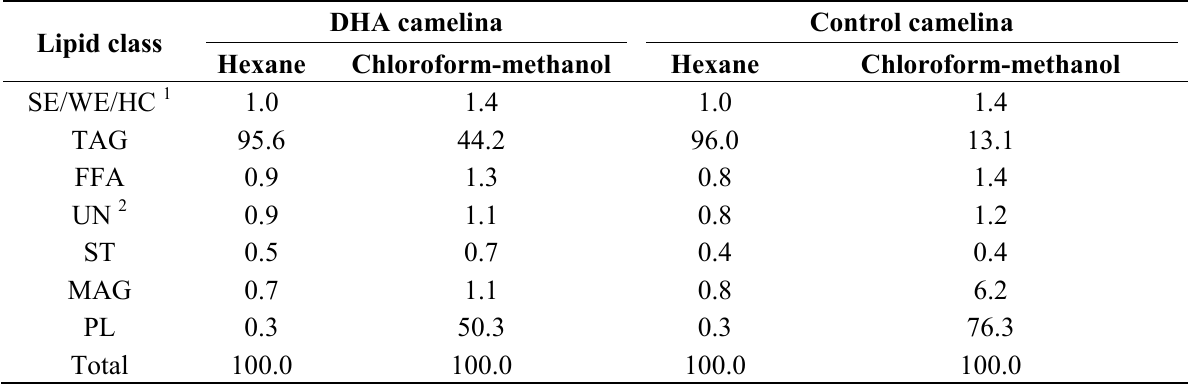
Table 2. Lipid class composition (% of total lipid obtained for each extraction step) of Hexane and CM extracts from DHA- and control Camelina sativa seeds.